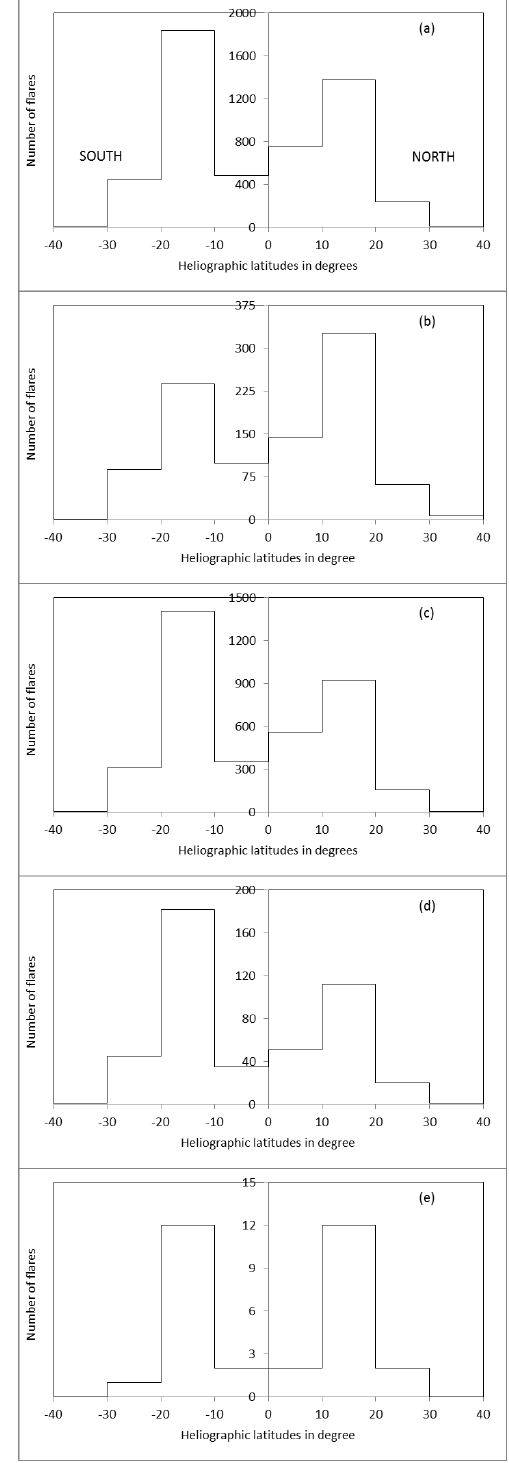
Figure 2. From top to bottom, plots of number of flares versus helio- graphic latitudes for a) Total, b) B-class, c) C-class, d) M-class and e) X-class SXR